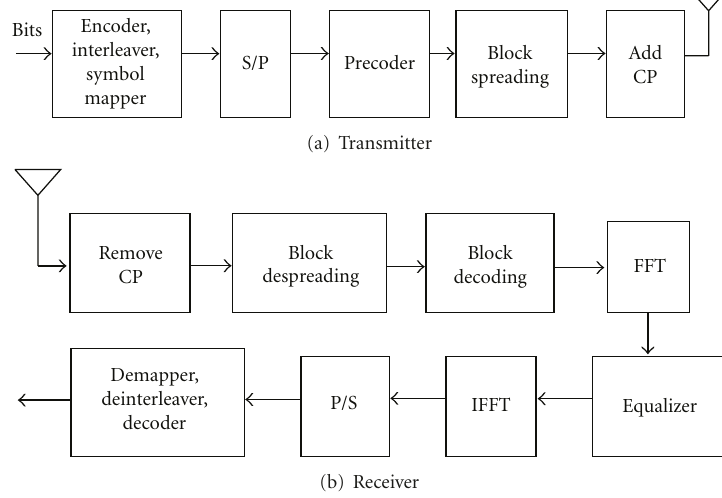
Figure 1: Transceiver of a synchronous BS-CDMA